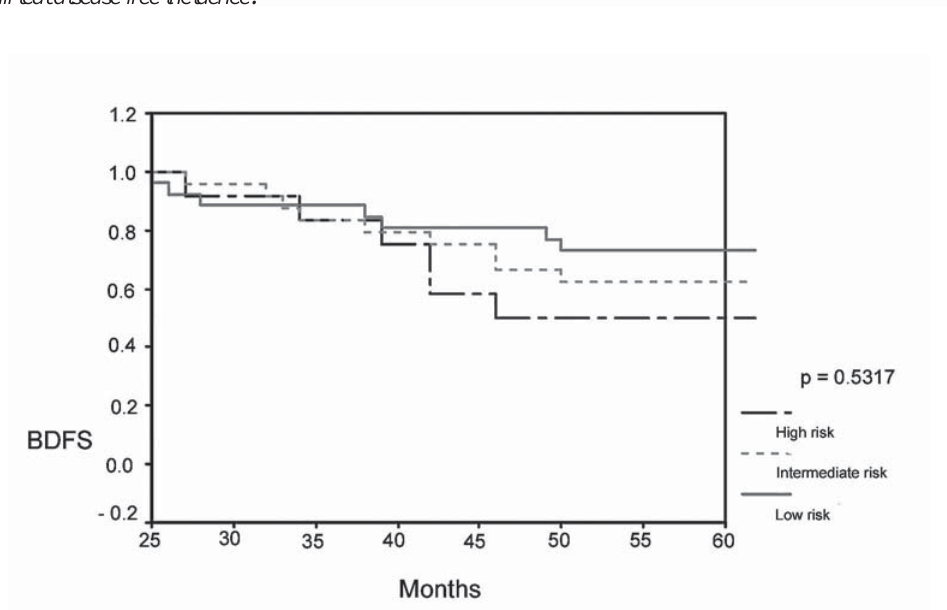
Figure 2 – Five years biochemical disease free survival (BDFS) for risk